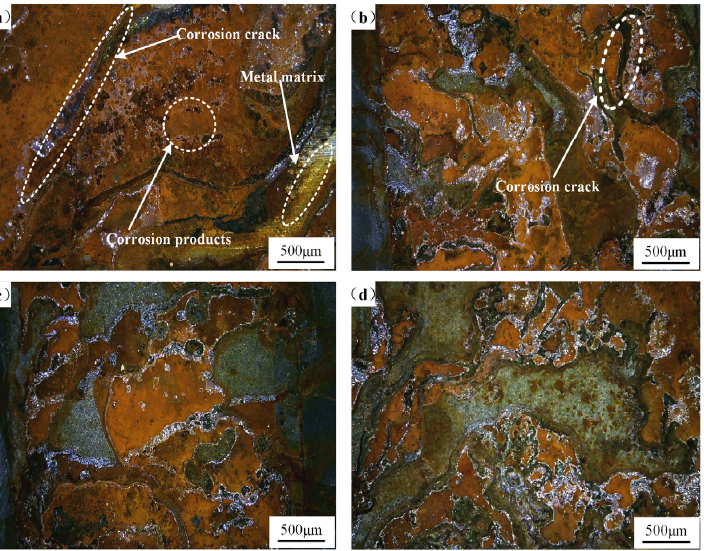
Figure 6. Macroscopic corrosion morphology of each sample: ( a ) the corrosion macro ‐ morphology of Sample polished; ( b ) the corrosion macro ‐ morphology of Sample USP; ( c ) the corrosion macro ‐ morphology of Sample DUSGP; ( d ); the corrosion macro ‐ morphology of Sample WUSGP.